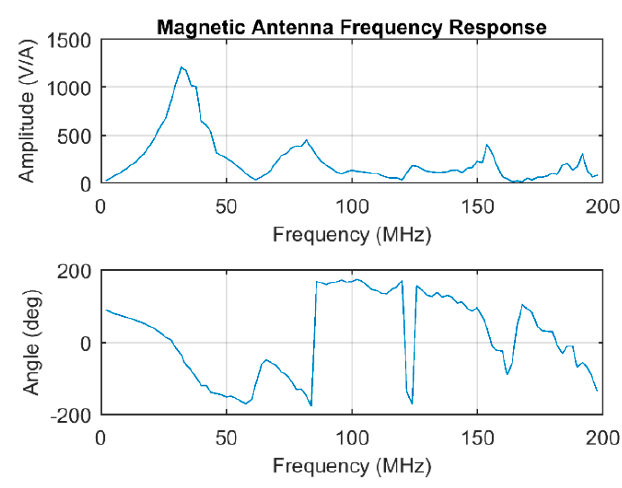
Figure 21. Magnetic antenna frequency response.